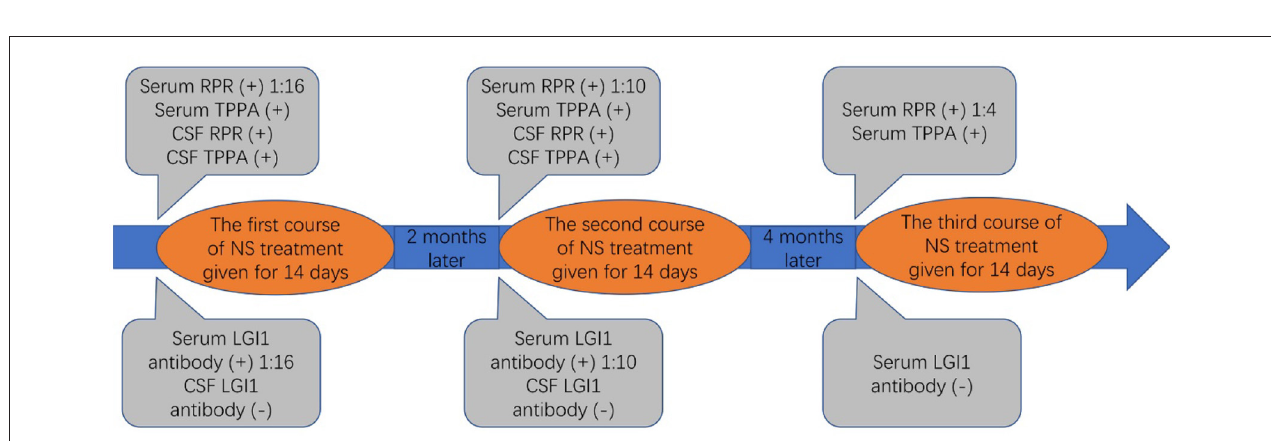
FIGURE 4 | The changes in syphilis and LGI1 antibodies over the course of syphilitic